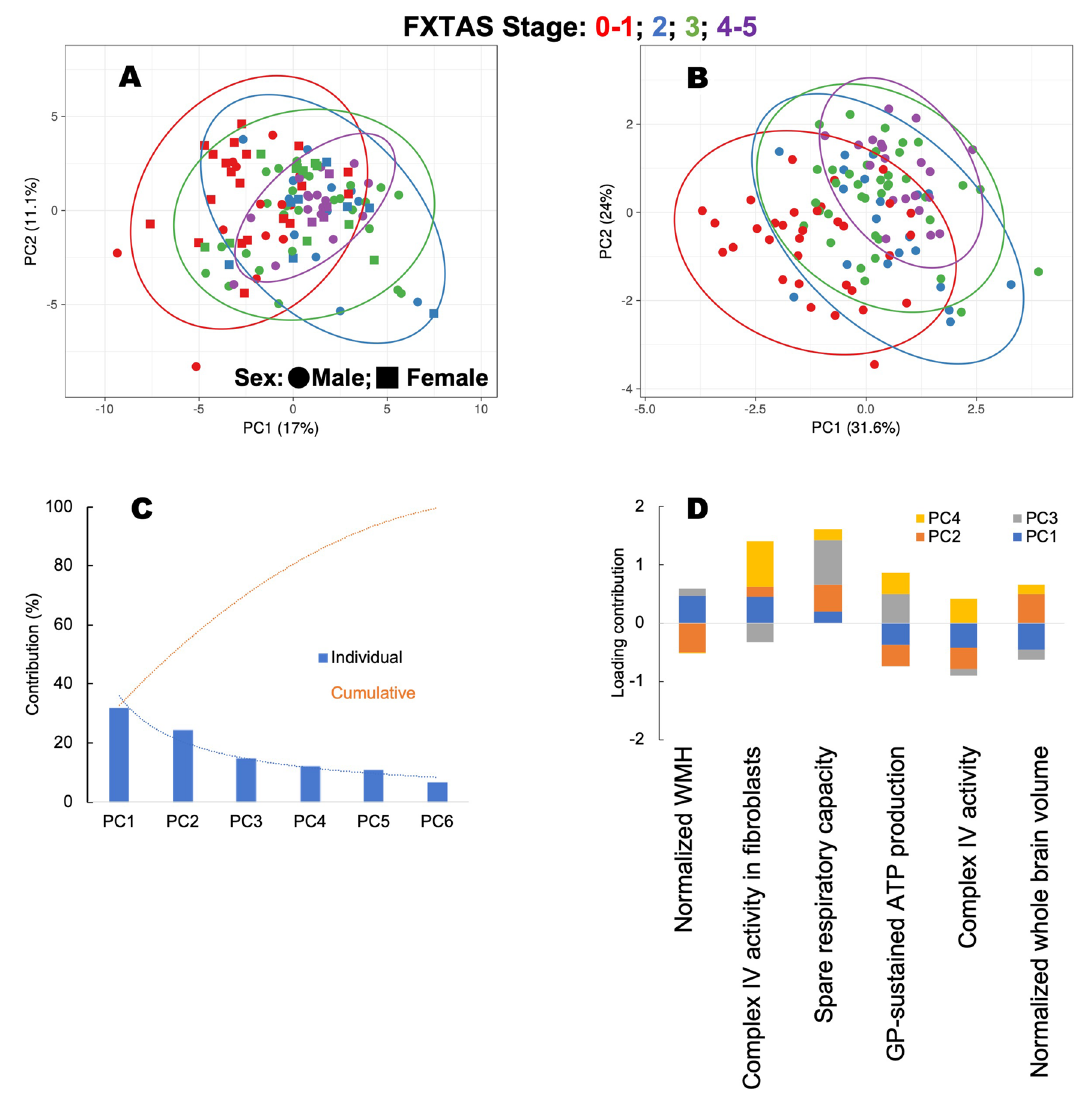
Figure 3. Principal component analysis of FXTAS stages based on sex, age, MRI findings, and bioenergetic outcomes. PCA (performed with ClustVis 2.0 119 ) was applied to the test dataset by utilizing all 111 carriers and either all outcomes as input (panel A ) or only those selected by VRE algorithm 81,82 (panel B ). Outcomes selected for panel B were taken from the decision tree in Fig. 2C. The data for constructing each PCA plot were scaled using a unit variance scaling applied to rows, and a singular value decomposition with imputation was used to calculate the principal component analysis method (for both panels). Other options were set as follows: no data transformation was used as the data were in the log form, no collapse of columns with similar annotations was performed, and no removal of constant columns was applied. ( A ) PCA of all subjects classified by stages by considering all parameters and outcomes (sex, age, diagnosed stage, and all bioenergetic and imaging outcomes). The X-axis and Y-axis show principal component 1 and principal component 2, which explain 17% and 11.1% of the total variance, respectively. The prediction ellipses demarcate the 0.99 probability that a new observation from the same group will fall inside the ellipse. ( B ) The sample analysis indicated under A was then performed only with the six (two imaging and four bioenergetic ones) outcomes selected by the VRE algorithm (from Fig. 2C). Using these parameters allows more precise separation of stages, as indicated by the larger variance contributions (principal component 1 and principal component 2 contributed to 31.6% and 24% of the total variance, respectively). Panels ( A , B ): Circles and square data points represent males and females, respectively; colors represented FXTAS stages: Stages 0–1 (red), blue (Stage 2), Stage 3 (green), and Stages 4–5 (purple). ( C ) A scree plot shows the individual contribution of the principal components (PC, blue bars) for explaining the variance in the data whose cumulative contribution (shown as a dotted orange line) accounts for 100% of the variance. PC1 and PC2 are the major contributors accounting for 57% of the variance. ( D ) A stack column plot shows the individual contribution of the six outcomes selected by the VRE algorithm on principal components 1–4 accounts for > 80% of the total variance. Imaging outcomes contribute mainly to PC1 (blue) and PC2 (orange); similarly, bioenergetic ones contribute to PC1-PC2 but also PC3 (grey) and PC4 (yellow). Bioenergetic outcomes were obtained with PBMCs except one indicated with “fibroblasts.” PC principal